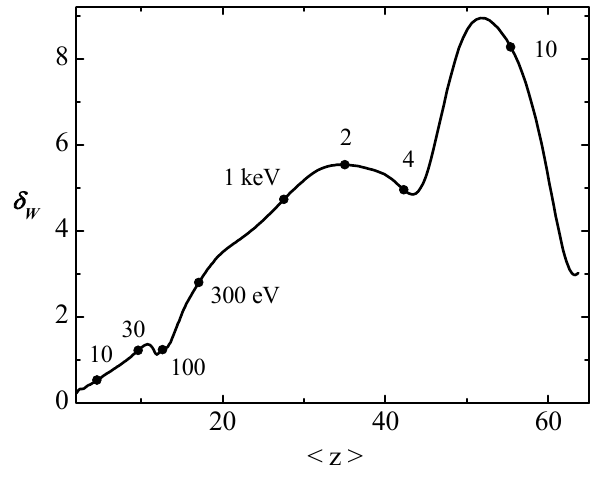
Figure 6. Dispersion of tungsten impurity in coronal equilibrium versus average charge of CSD: calculated from the data of AIM-ADPAK code [1] for ionization and recombination rates (the corresponding T e values are noted by points along the